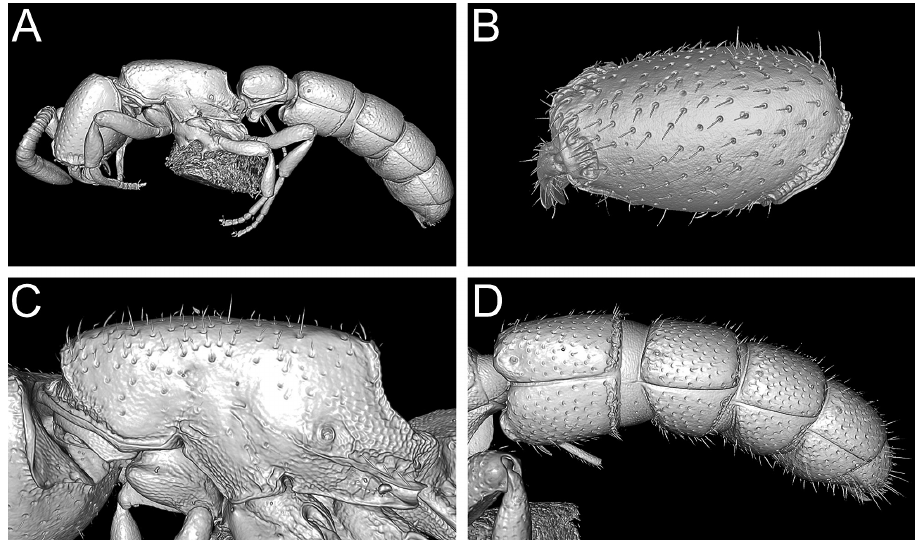
Figure 16. Comparison of full body scan versus single body part scans based on Zasphinctus oba- mai sp. n. holotype (CASENT0764125) and paratype worker (CASENT0764127). A Full body scan (CASENT0764125) B Scan of head (CASENT0764125) C Scan of mesosoma (CASENT0764127) D Scan of metasoma showing abdominal segments III to VII in profile